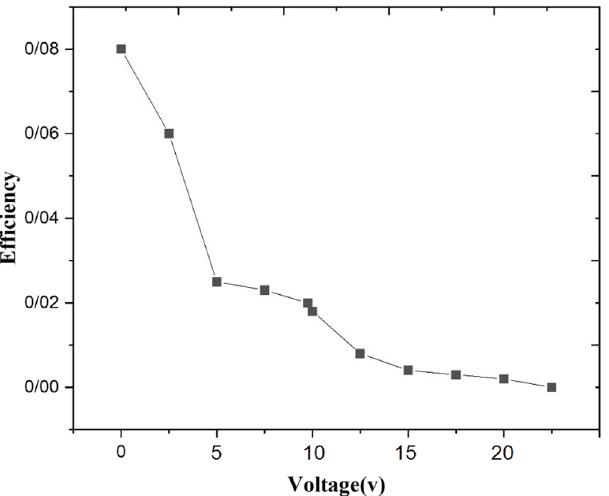
Figure 15. The plot of first order diffraction efficiency versus the applied voltage.